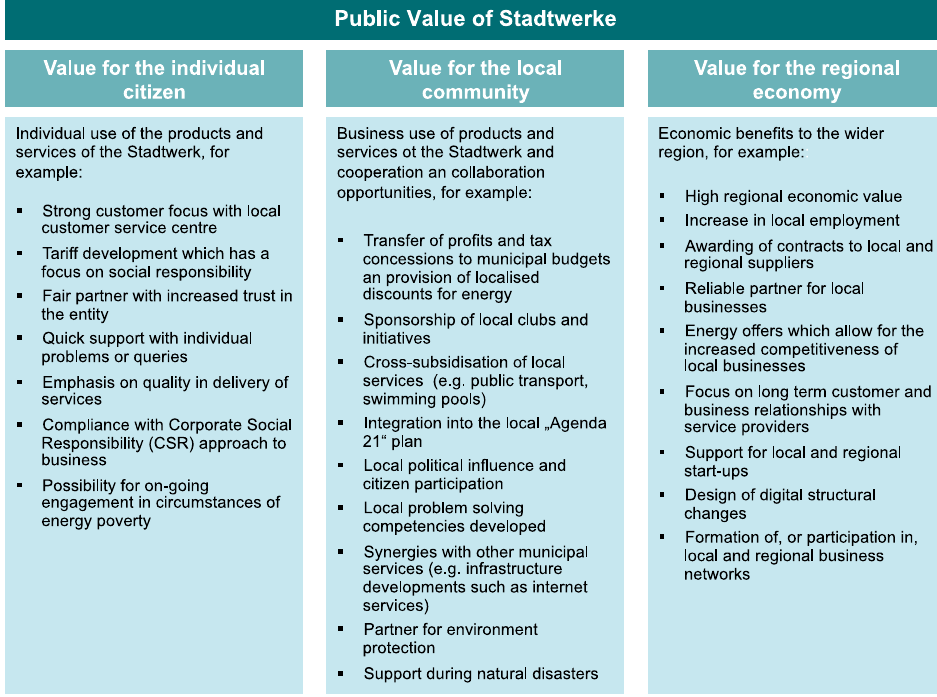
Figure 2. Public value of Stadtwerke Source: Own figure, based on [44].